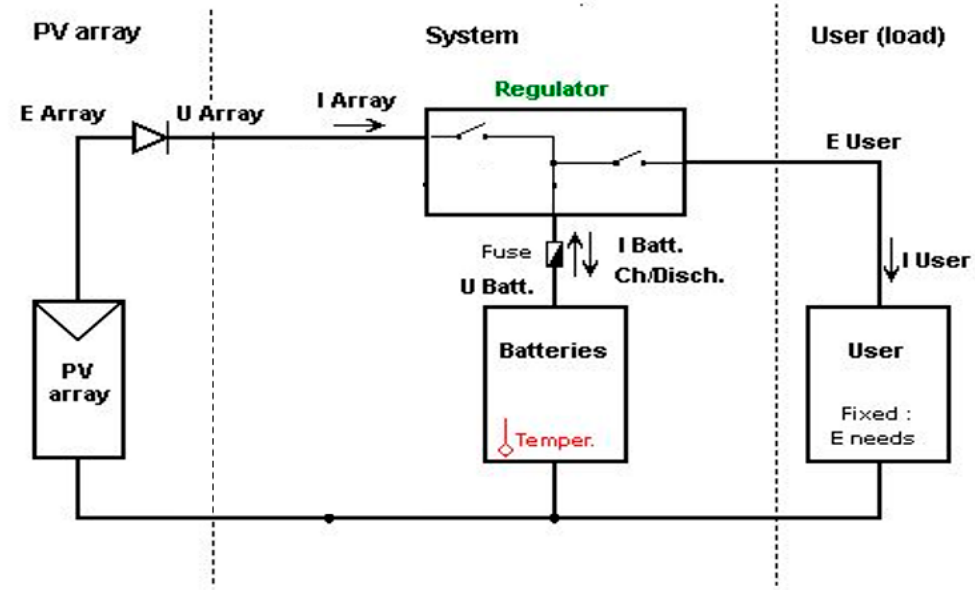
Figure 10. Single line diagram of the charging station.